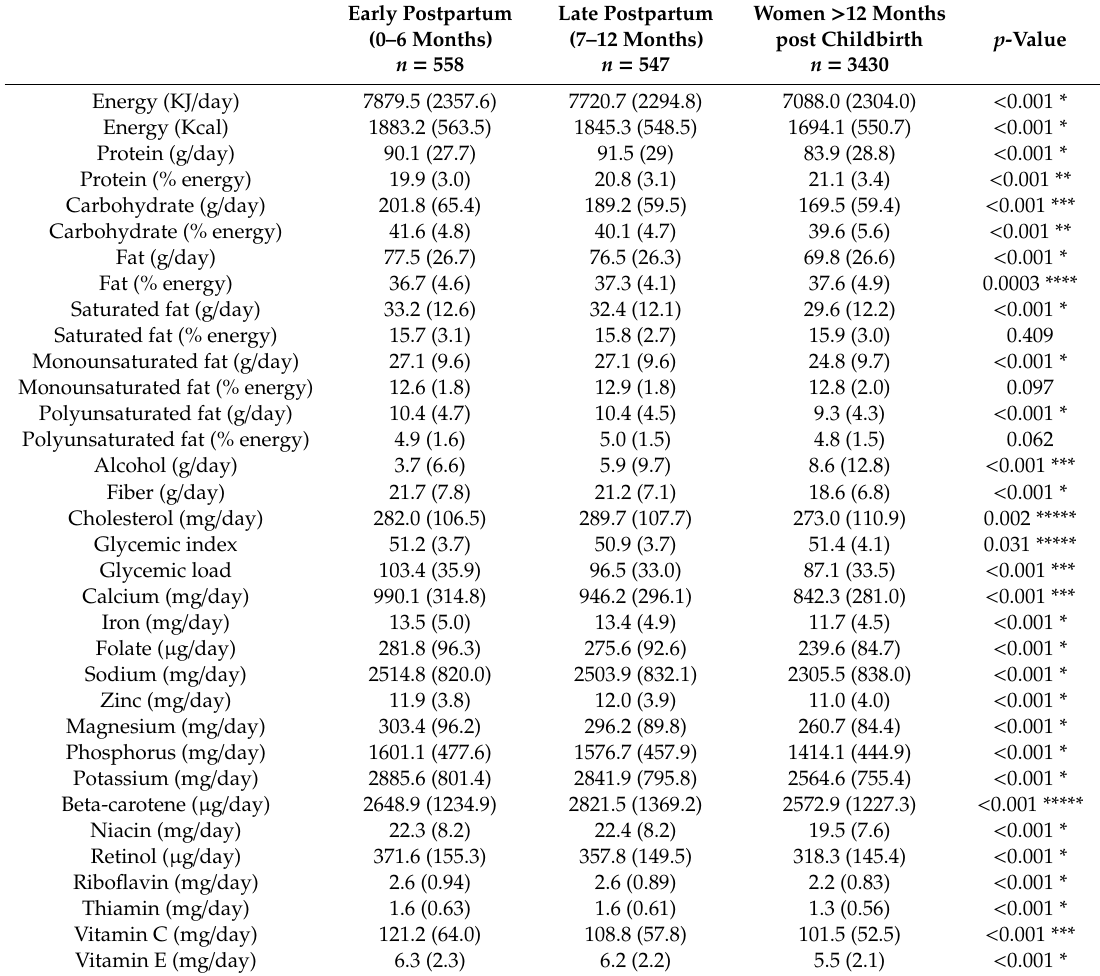
Table 2. Energy, macronutrient, and micronutrient intake in women categorized by their time since